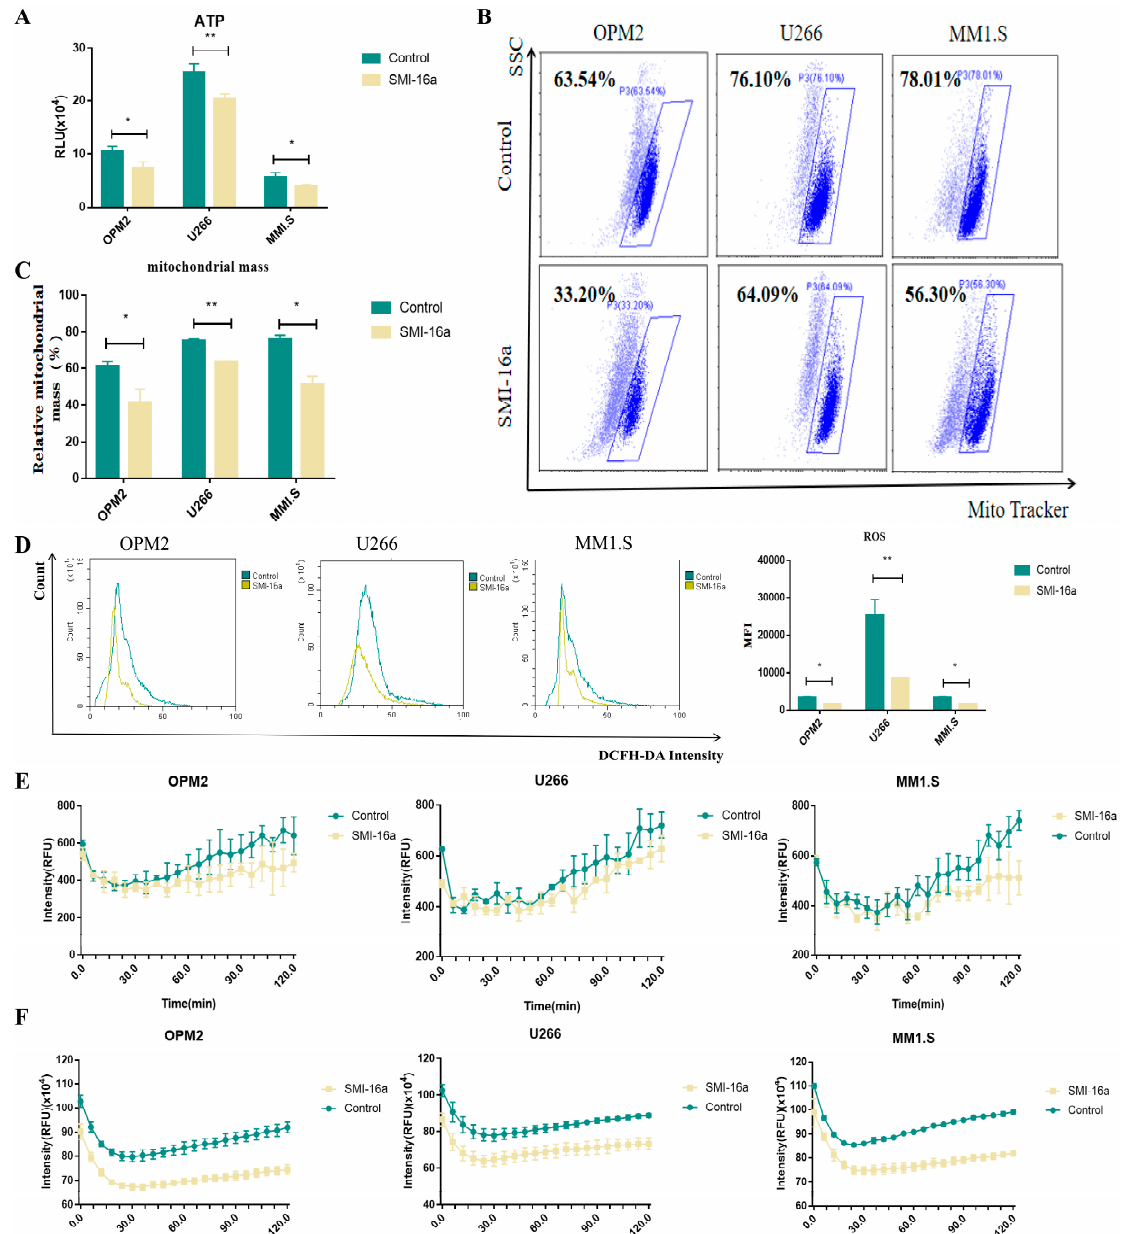
Figure 4. Pim-2 is involved in energy metabolism through participation in aerobic oxidation and glycolysis. ( A ). Detection of ATP production levels in different treatment groups. In different MM cells, ATP levels were lower in the SMI-16a-treated group than in the control group. ( B ). The detection of cellular mitochondrial mass after MM cell lines were treated with SMI-16a for 48 h. ( C ). The total percentage of mitochondrial mass in different cells. ( D ). Total percentage of ROS in different cells. ( E ). Oxygen consumption analysis. Control and SMI-16a groups were measured by fluorescence spectroscopy over 90 min and compared for fluorescence emission. ( F ). Glycolysis assay measured as cytoplasmic acidification. Glycolysis was measured in Control and SMI-16a groups by fluorescence emission over 90 min. Each group of experiments was repeated 3 times. * Indicates a significant difference compared with the HC group, p < 0.05. ** Indicates a significant difference compared with the HC group, p <